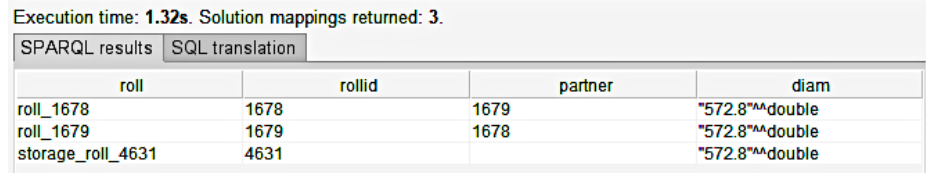
Figure 8. SPARQL result from Listing 2.